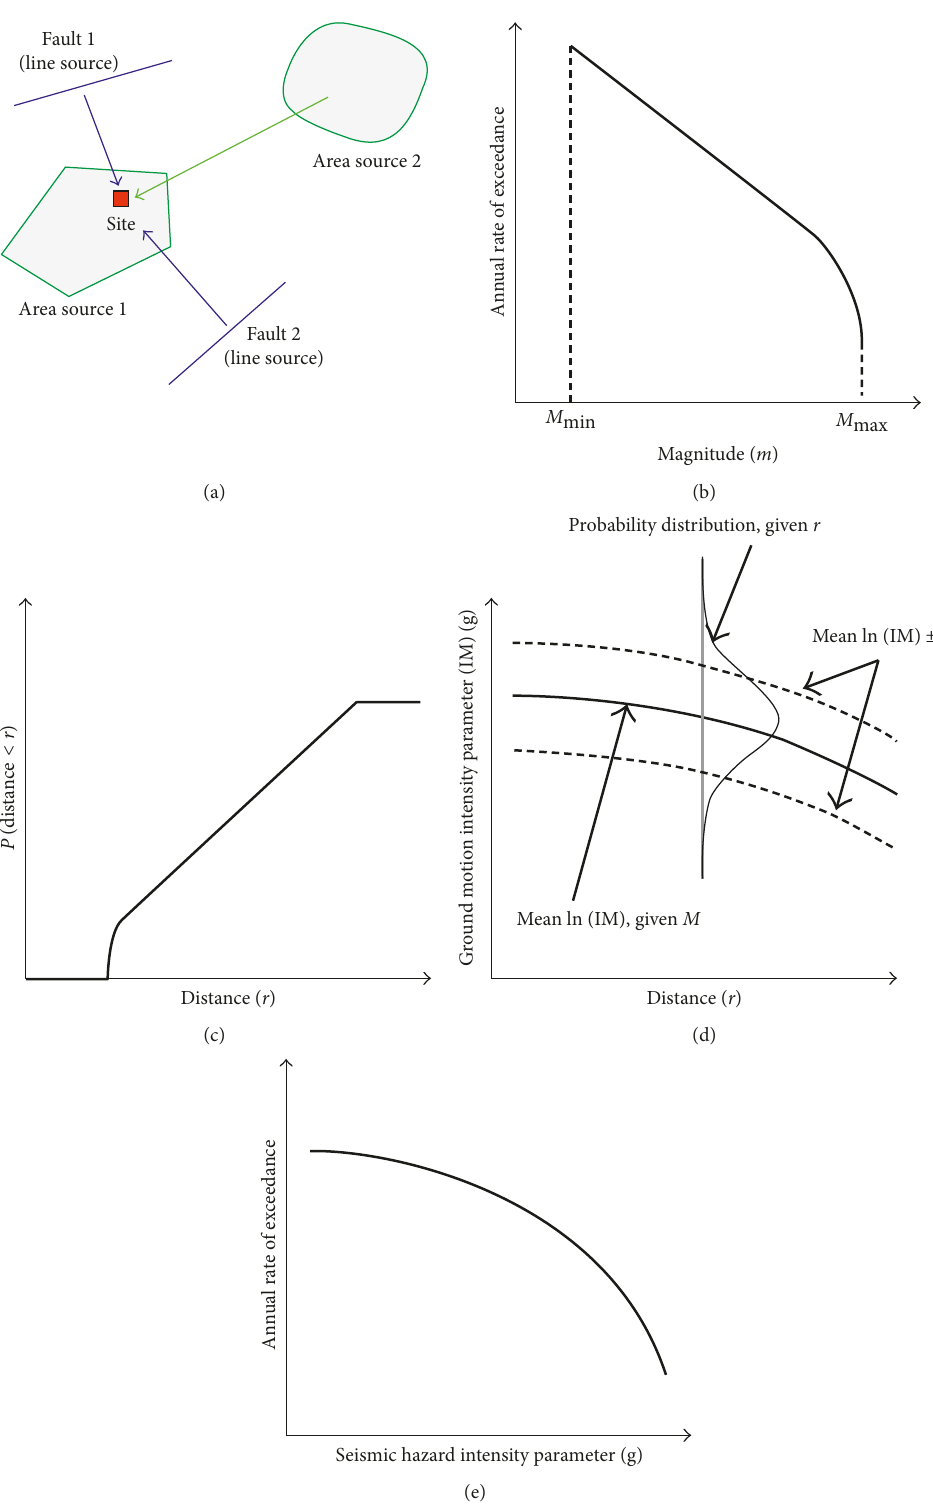
Figure 1: Conceptual image of the five key steps in a PSHA: (a) Step 1: identify the earthquake sources; (b) Step 2: define the distribution of the earthquake magnitude; (c) Step 3: define the distribution of earthquake distances; (d) Step 4: set the ground motion prediction model; (e) Step 5: annual rate of exceeding the seismic hazard intensity as determined by combining steps